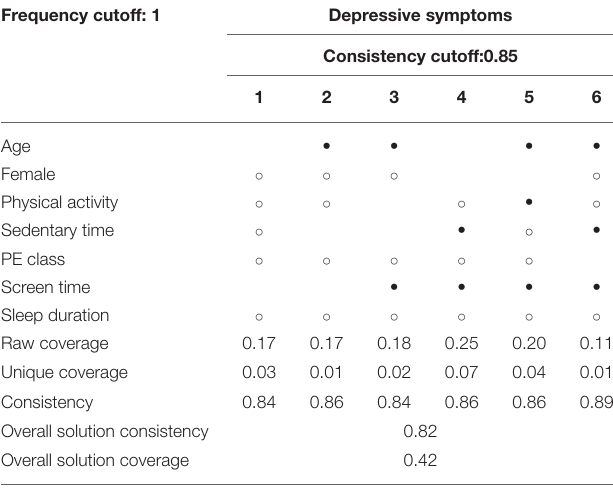
TABLE 4 | Summary of the three main sufficient conditions for the intermediate solution of depressive symptoms. Frequency cutoff: